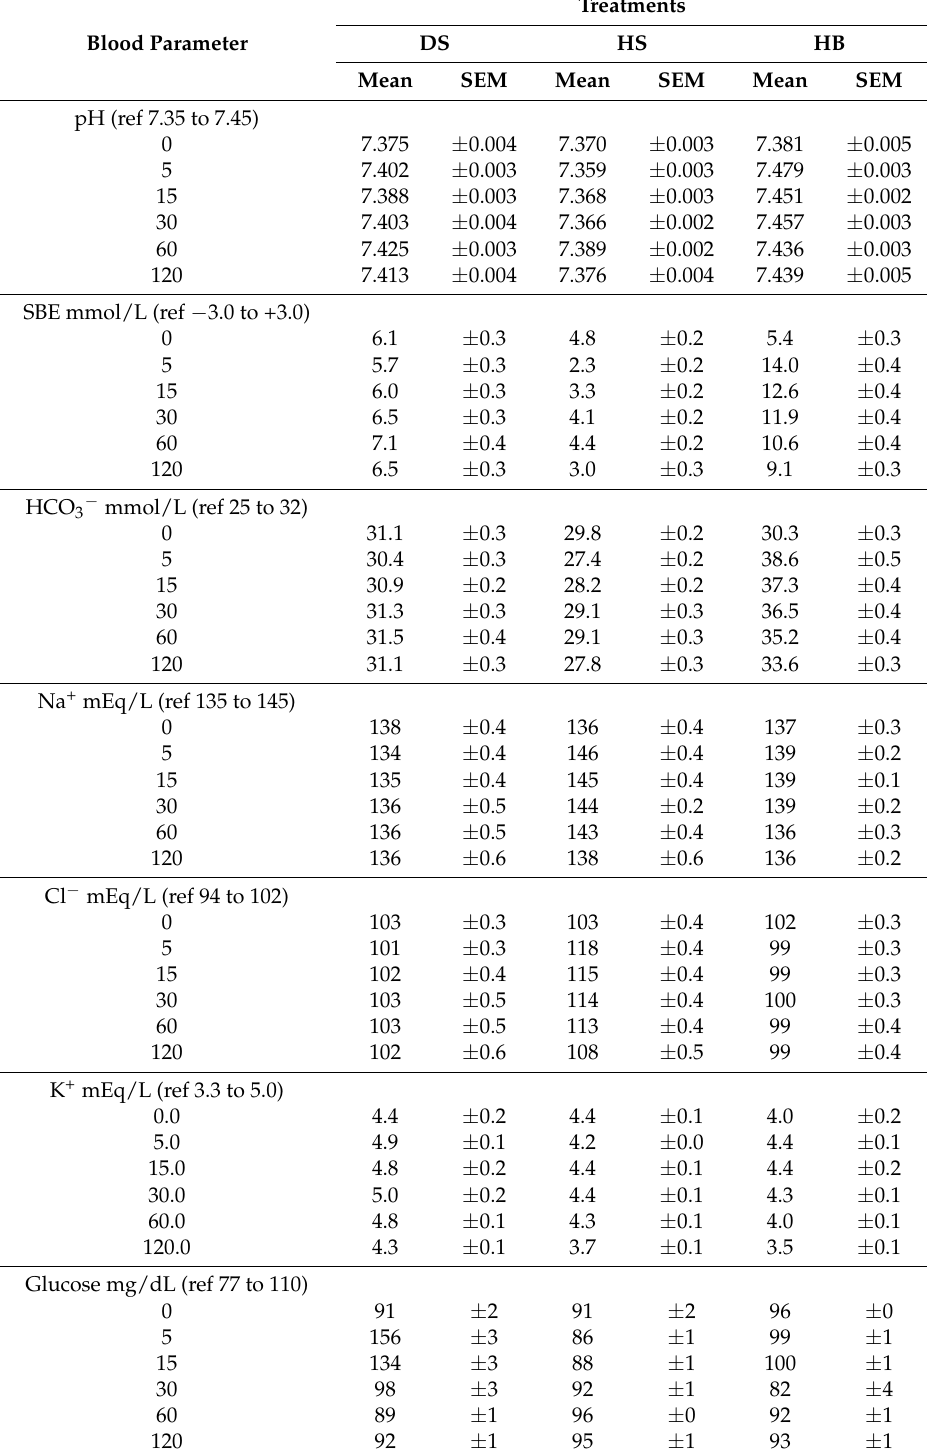
Table 5. Blood Analysis Variable. Changes in blood variables following intravenous infusion of DS, HB, and HS. DS (5% dextrose solution at 2 mL/kg bwt), HB (NaHCO 3 8.4% solution at 2 mmol/kg bwt), and HS (NaCl 7.5% solution at 4 mL/kg bwt). Numbers in bold for the following parameters: pH, HCO 3 , Na + , Cl − , K + , glucose, Ca 2+ , tMg, and Mg 2+ indicate values above or below the reference range for that blood parameter. Note: For SBE, the baseline values for all horses were above the reference range. For this parameter, bold indicates difference from baseline